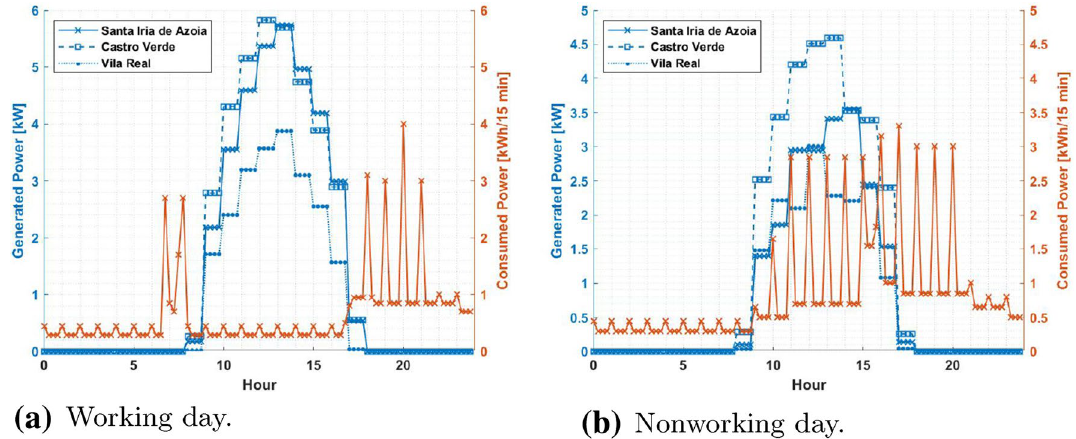
Fig. 15 Generation and consumption curves on the two significant days of January for c-Si NWs